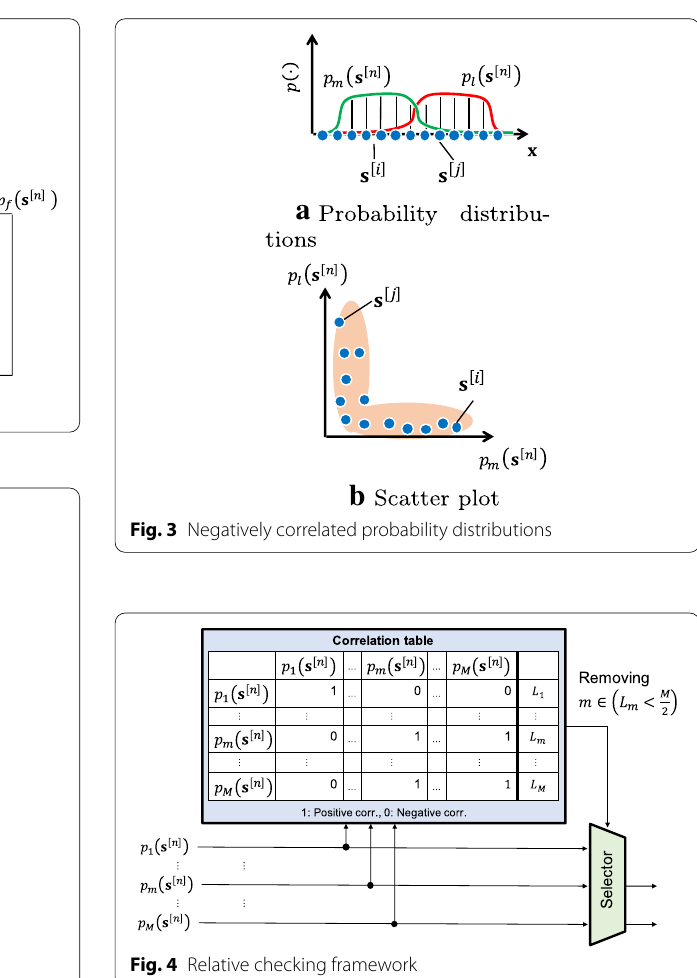
Fig. 2 Positively correlated probability distributions